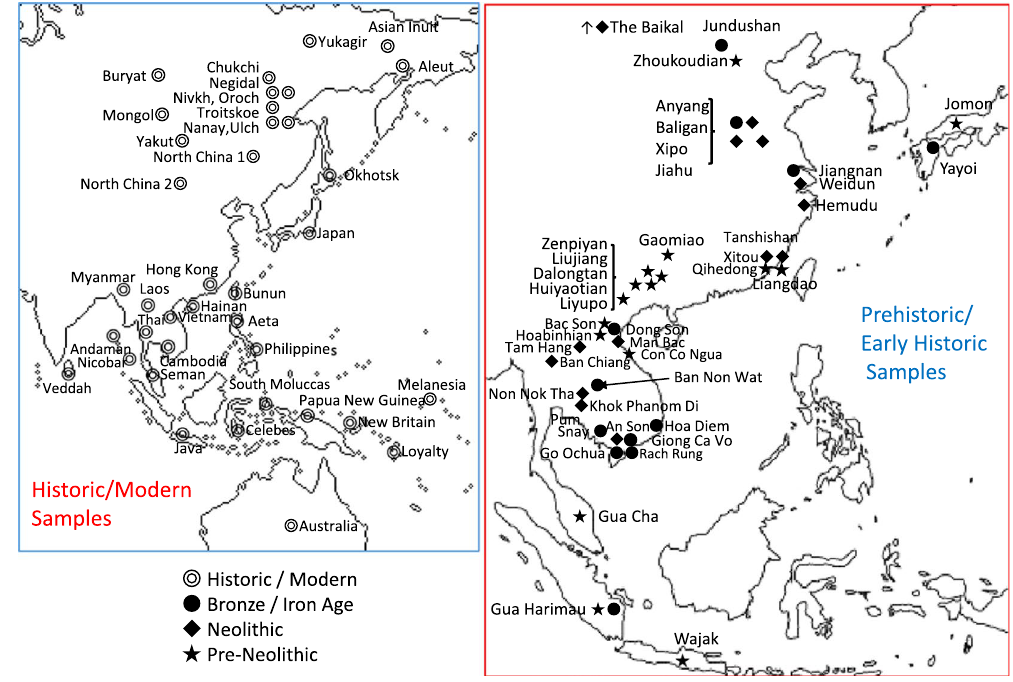
Figure 1. Map showing comparative sample